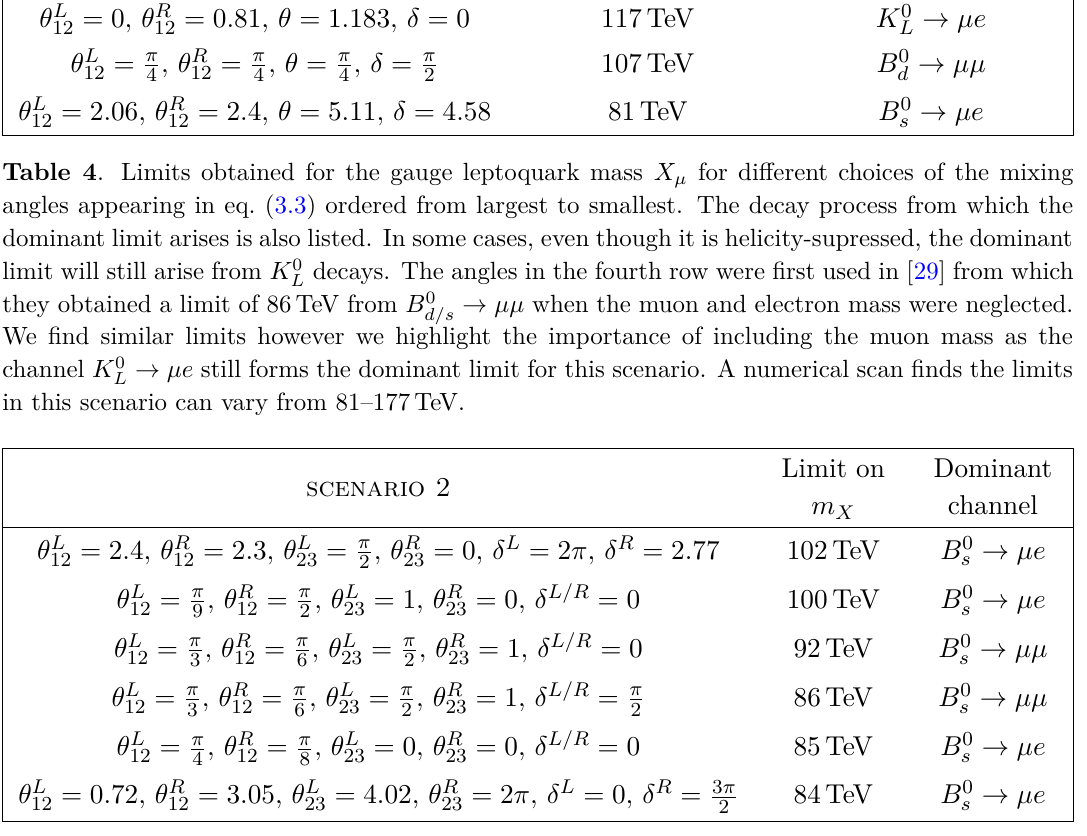
Table 5 . Limits obtained for the gauge leptoquark mass X µ for some different choices of mixing angles appearing in eq. (3.5) ordered from largest to smallest. The decay process from which the dominant limit arises is also listed. Here the decays of K 0 are completely forbidden and the L dominant limit will always arise either from B 0 → µµ or B 0 → µe . Through a numerical scan s s we find the mass of the PS leptoquark varies between roughly 84 – 102 TeV depending on different choices of mixing angles, a much closer range compared to the results of Scenario